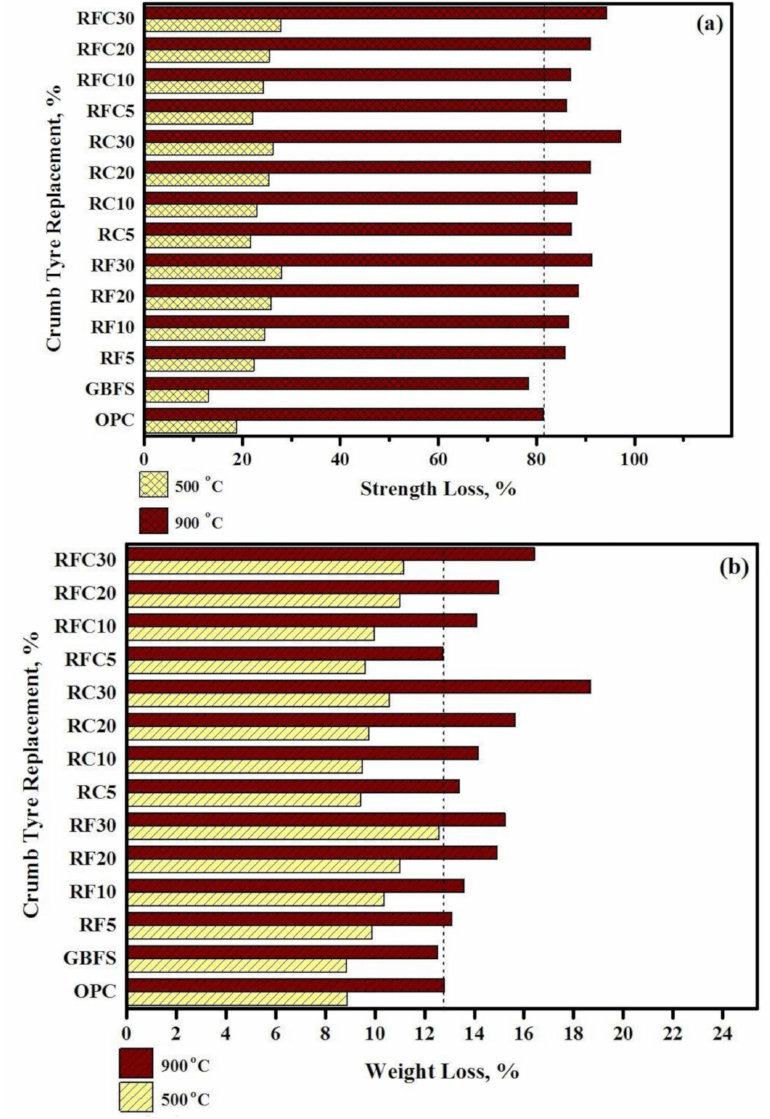
Figure 9. Effect of elevated temperatures on ( a ) CS and ( b ) weight loss of modified rubberized